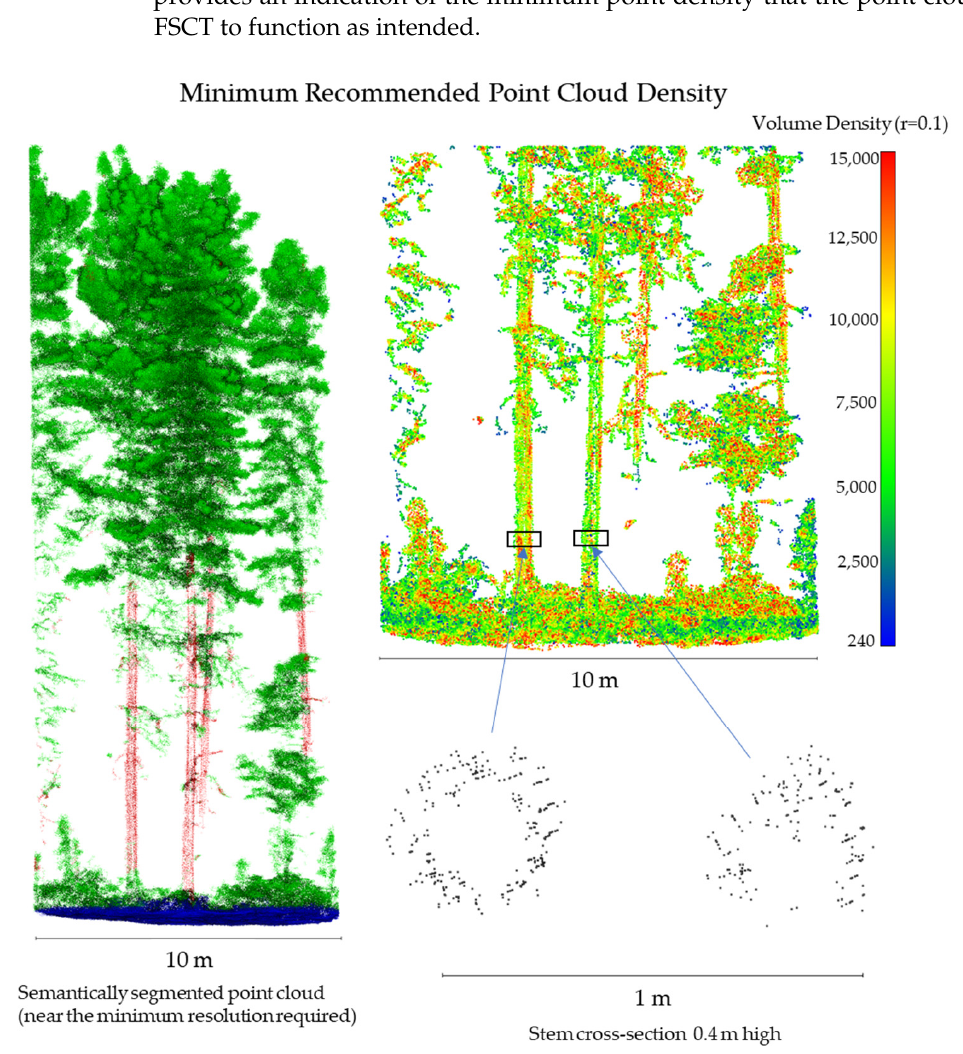
Figure 2. Left shows an example of an aerial laser scanned point cloud, which is approaching the lower limit of resolution that FSCT was designed to tolerate. Top-right shows this same dataset with the volume density (ball radius = 0.1 m) shown, and bottom-right shows 0.4 m tall cross sections of two of the trees.